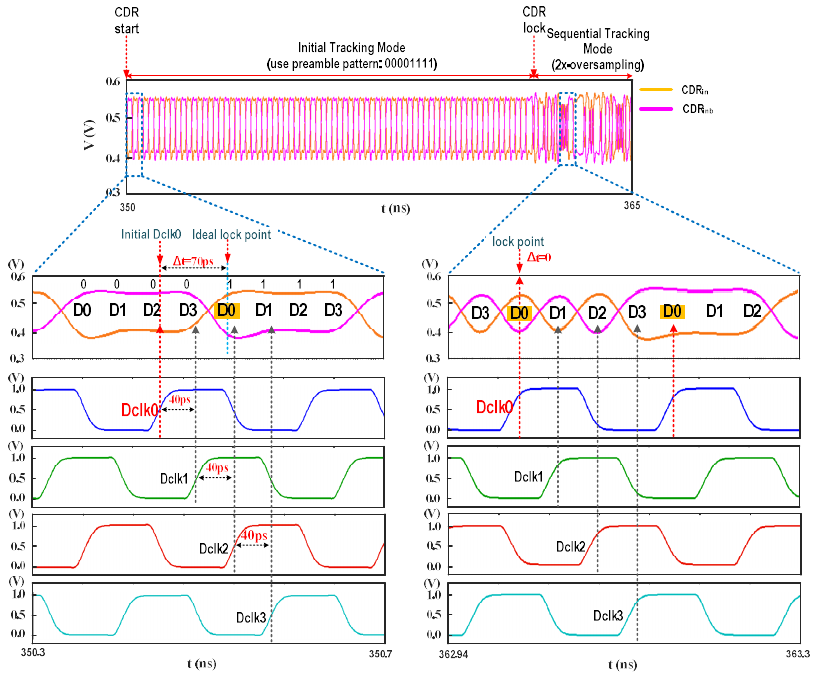
Figure 12. Simulated locking process of the proposed CDR at 25 Gb/s.